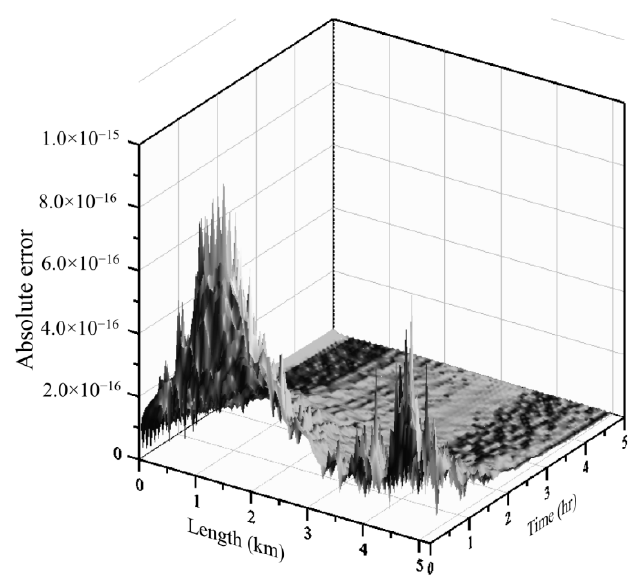
Figure 6. Result comparison of example 2.